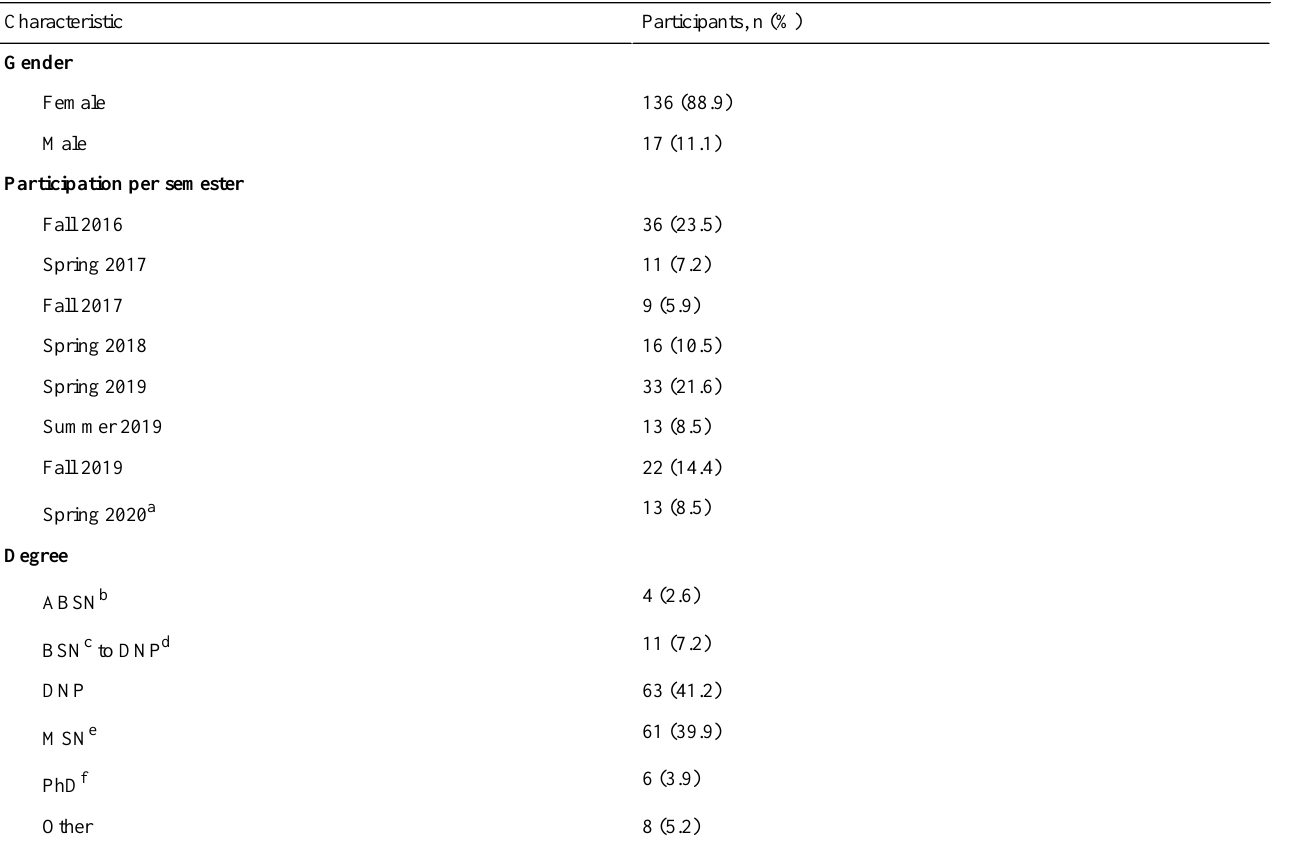
Table 1. Descriptions of study participants (N=153).